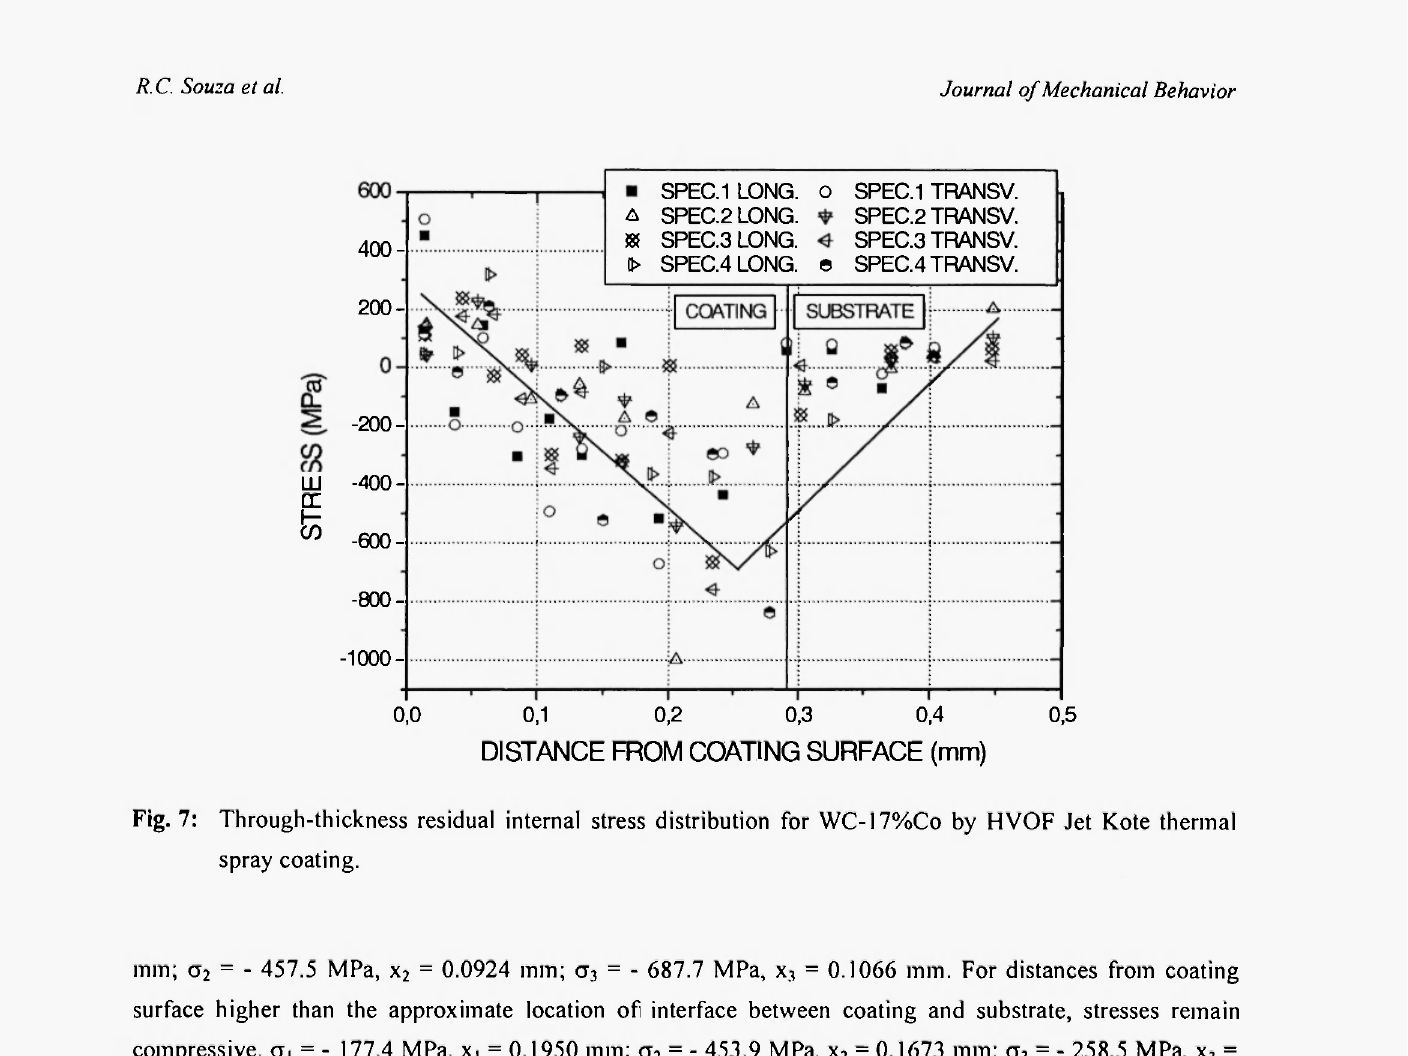
Fig. 7: Through-thickness residual internal stress distribution for WC-17%Co by HVOF Jet Kote thermal spray